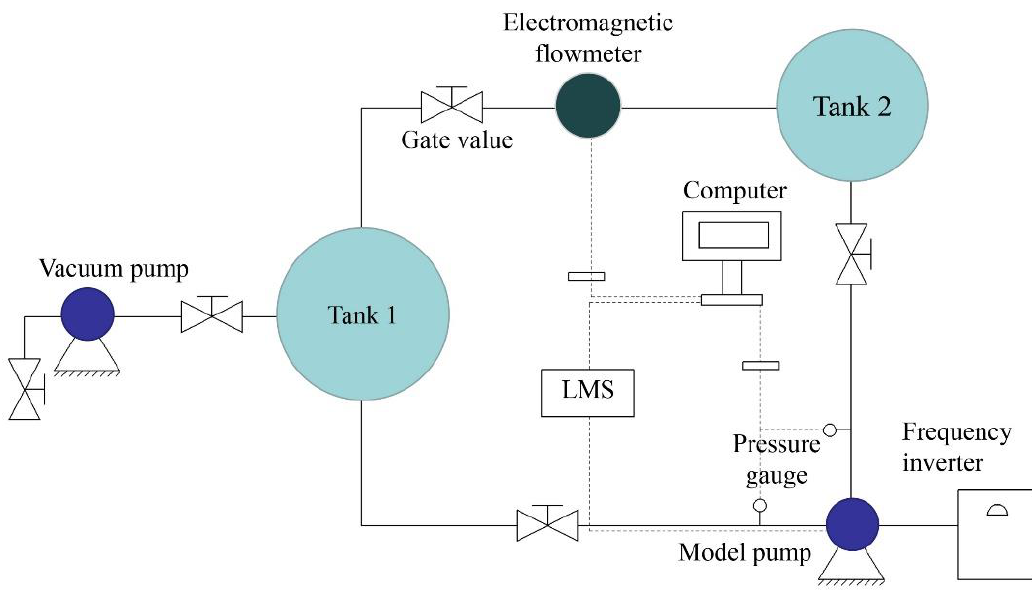
Figure 2. Closed test platform.